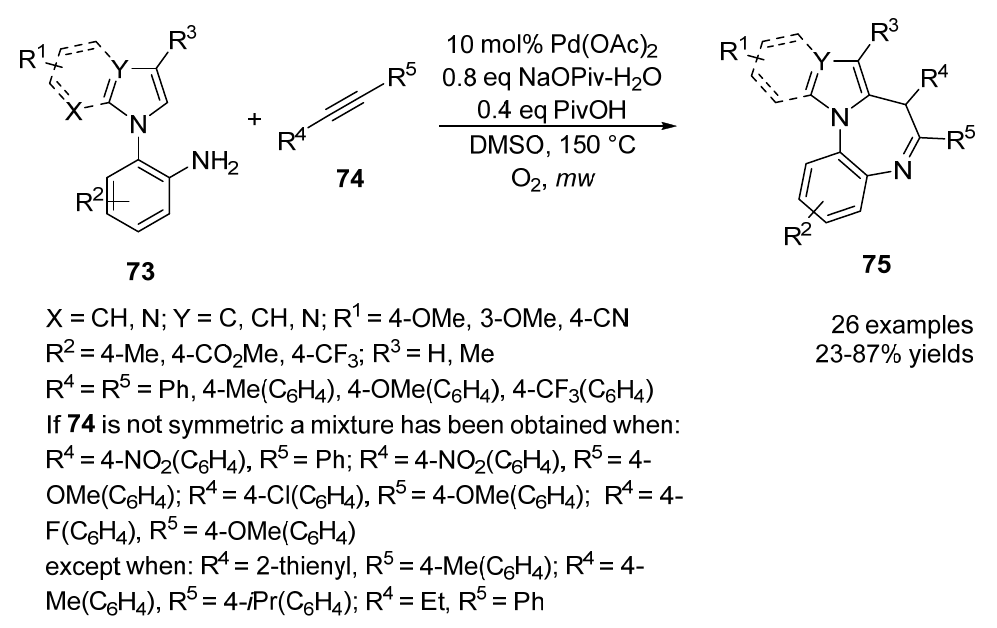
Scheme 36. One-pot synthesis of 1,2-fused indole-diazepines 75 .